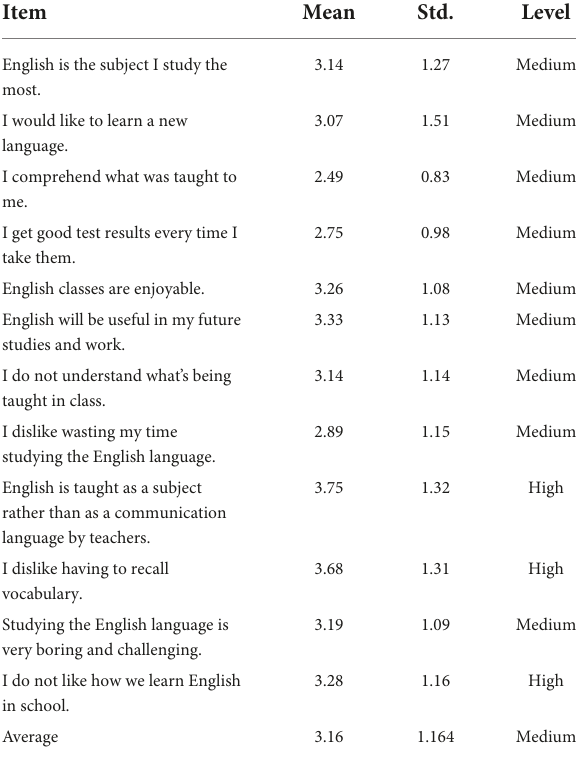
TABLE 1 English as a foreign language (EFL) students’ attitudes toward learning the English language. Item Mean Std.